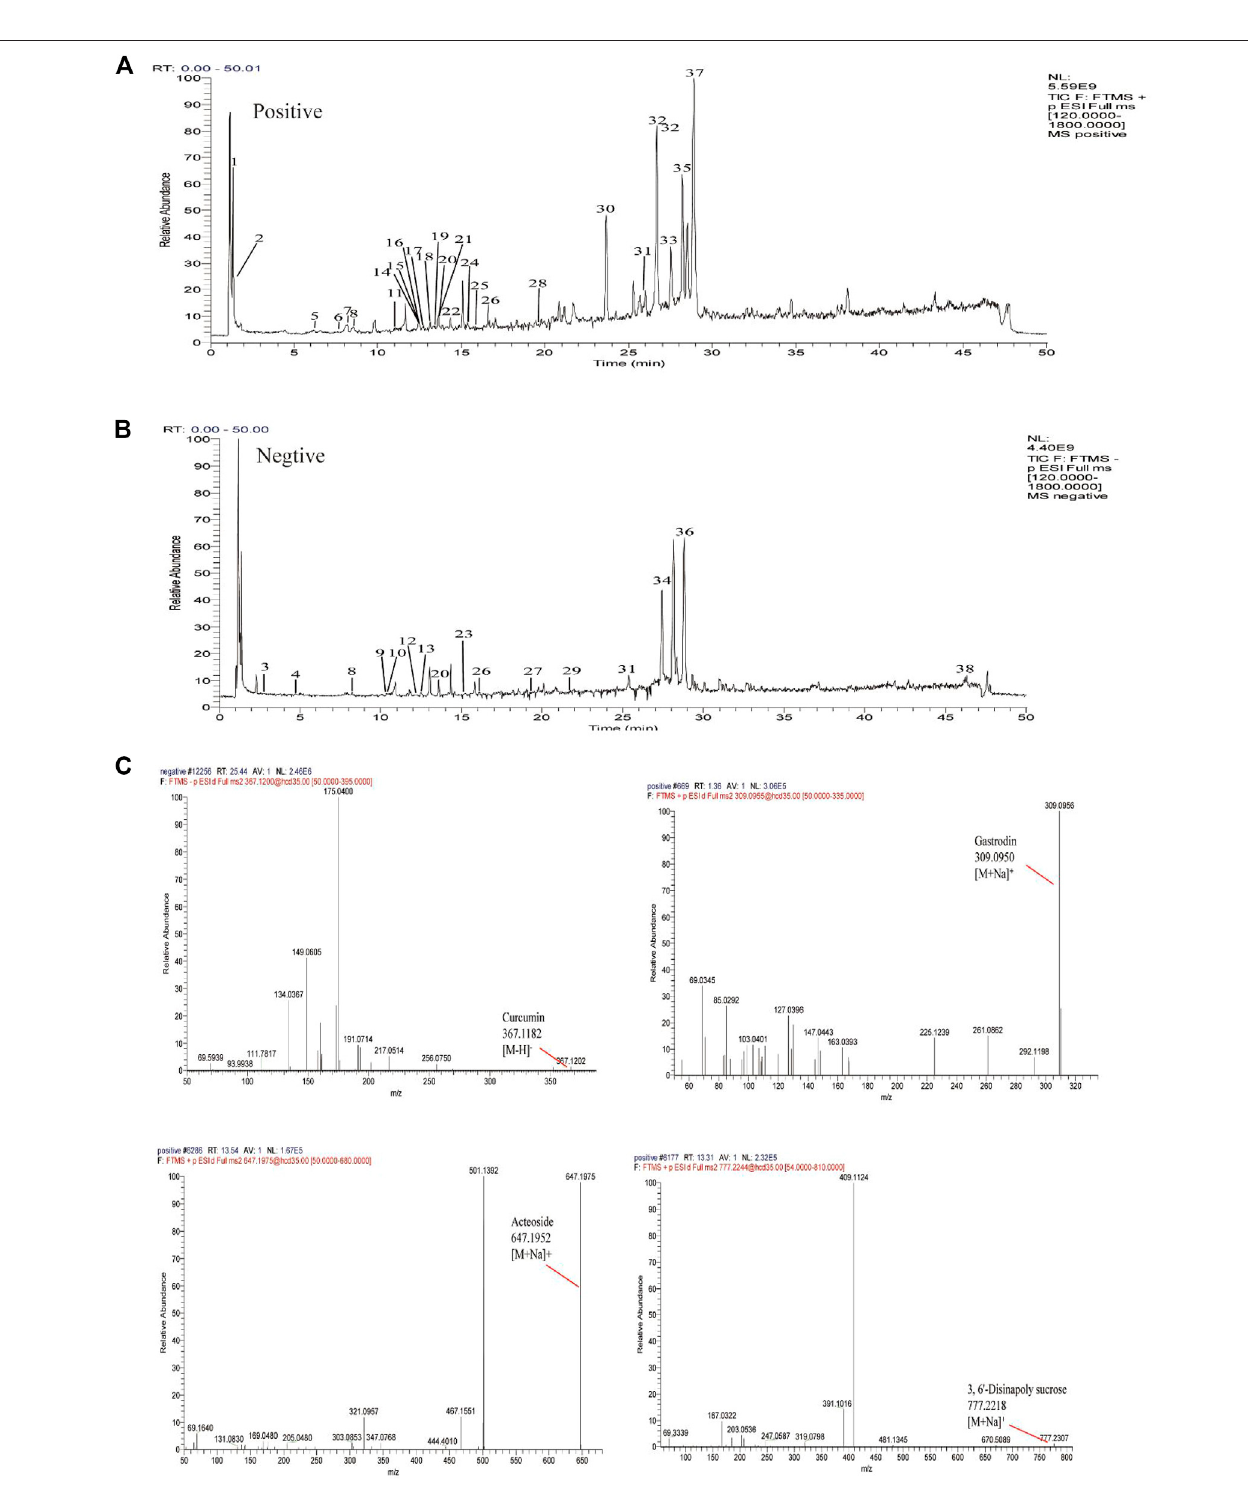
FIGURE 3 | Total ion chromatogram monitored in positive (A) and negative (B) ion modes for GPCRAC extracts; GPCRAC extracts composition analysis: GPCRAC extracts has Gastrodin, 3, 6 ′ -Disinapoly sucrose, Echinacoside, Acteoside, Curcumin and other ingredients (C) .